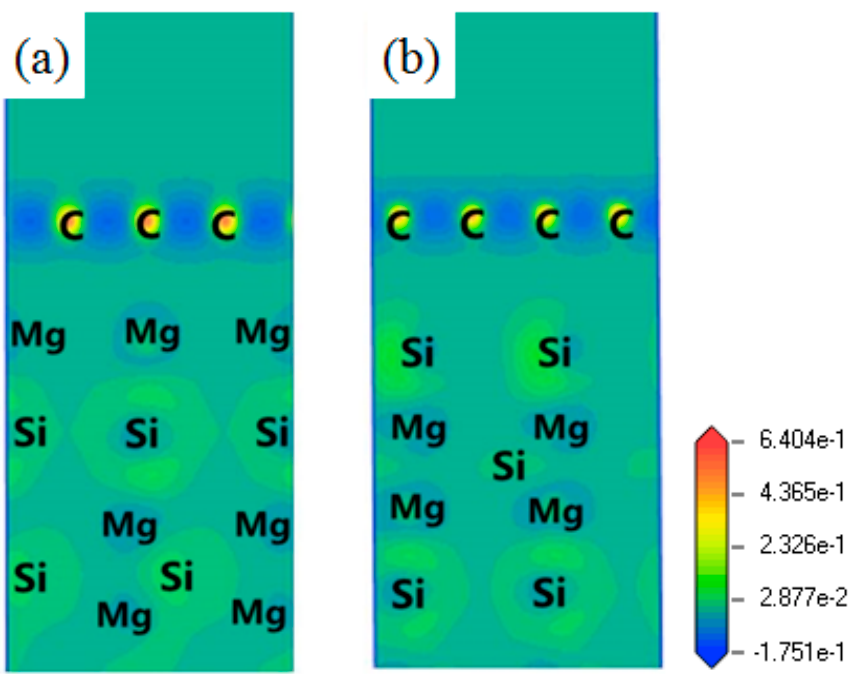
Figure 10. The charge density difference diagram for Mg 2 Si (111)/Gr (0001) interfaces: ( a ) Mg- termination; ( b ) Si-termination.